Question: What does this figure show? Answer in one sentence.
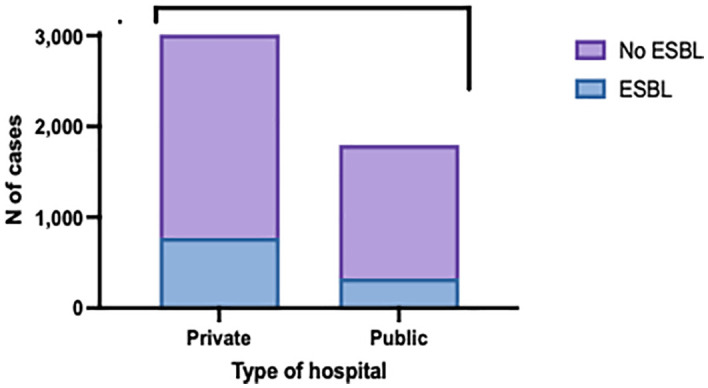
Answer: ESBL frequency according to hospital type in Meta Department hospitals. The figure compares the proportion of presumptive ESBL-producing Klebsiella pneumoniae isolates between public and private hospitals during 2018–2022. Bars represent percentages of ESBL-positive isolates in each hospital type. ESBL = extended-spectrum beta-lactamase. Source: Original from the authors.